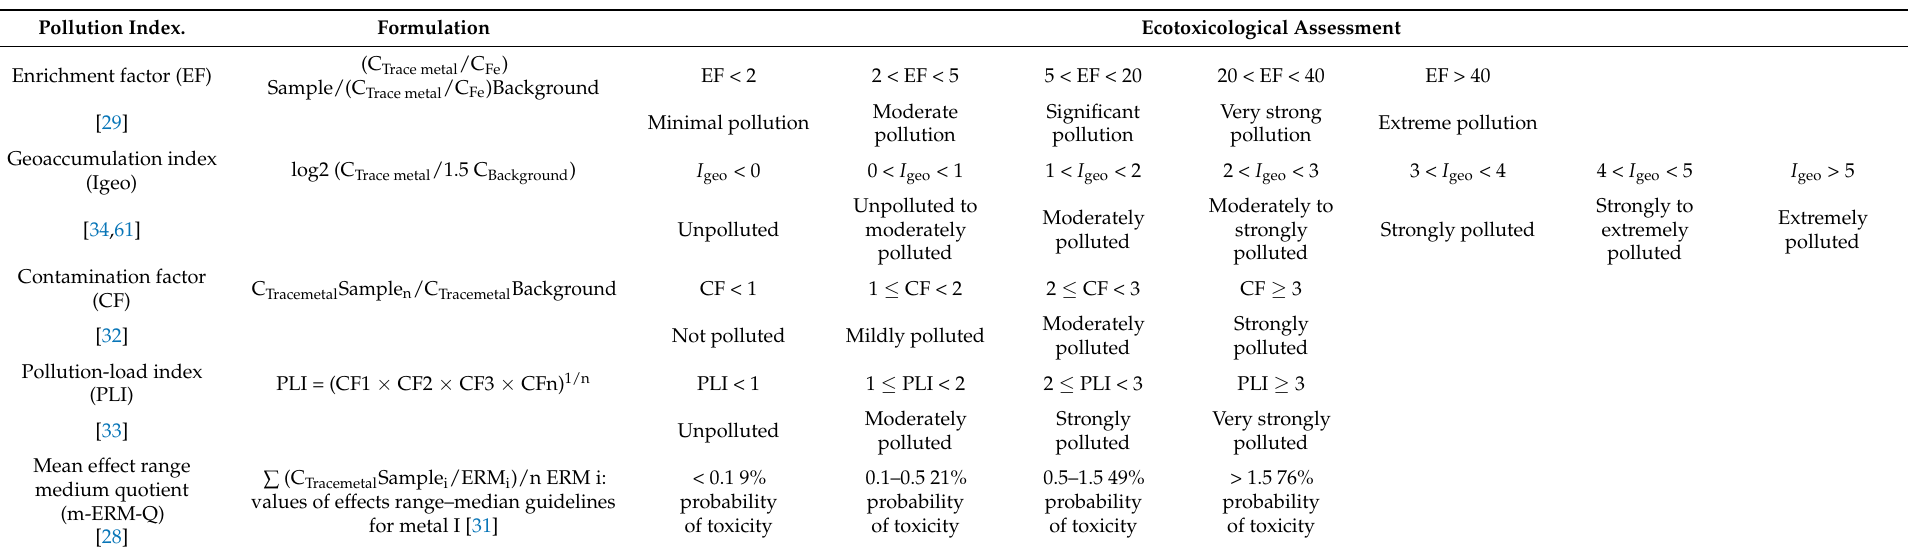
Table 1. Metal pollution index and